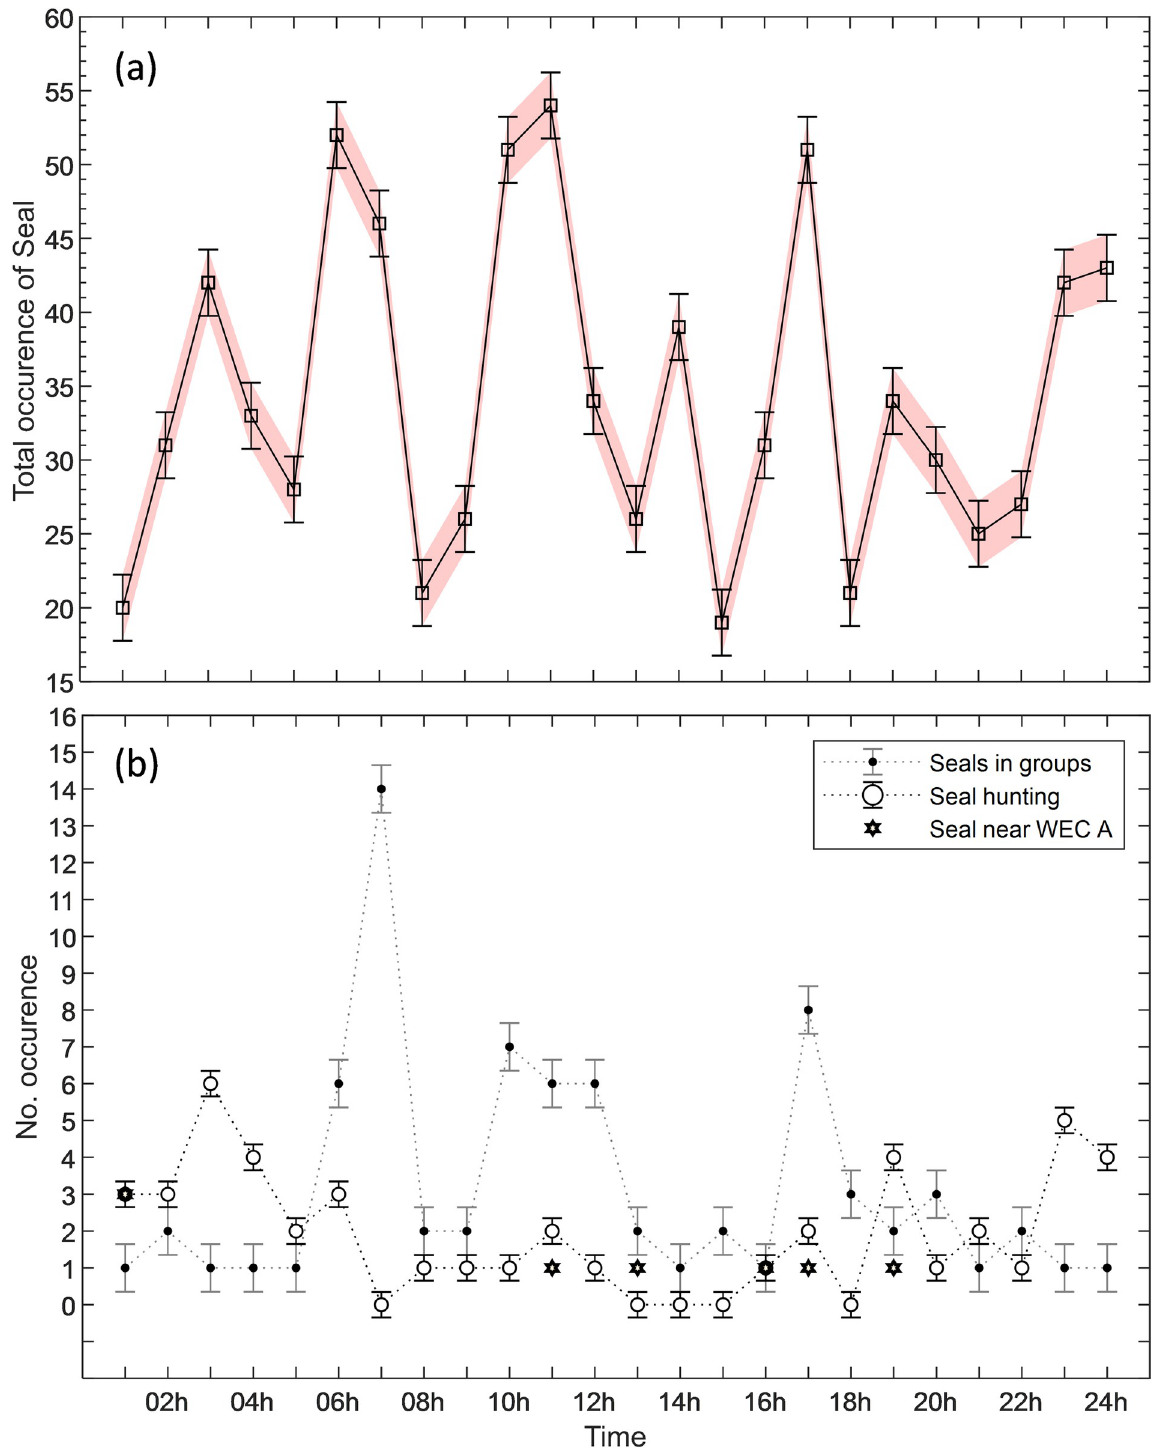
Fig 12. Temporal variability, occurrence, and behaviour of seals. (a) Total occurrence of observed seals per hour; (b) Total occurrence of seal swimming in groups, engaged in hunting, and swimming close to WEC A. The standard error is represented by the error bars with caps.